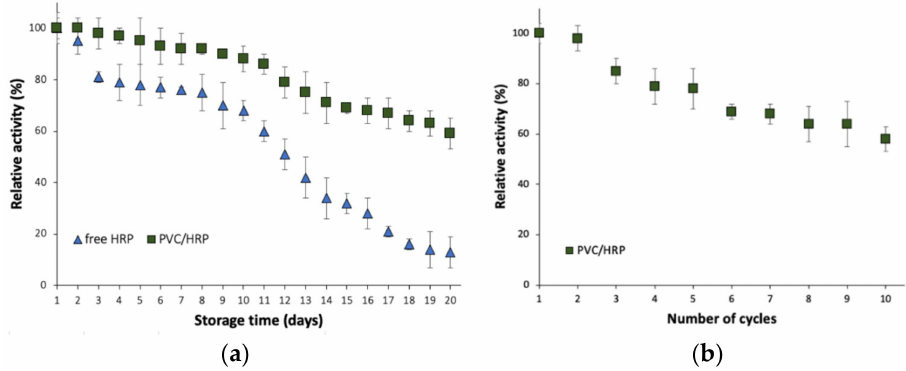
Figure 2. ( a ) Storage stability of the free and immobilized HRP; ( b ) reusability of the PVC/HRP-based